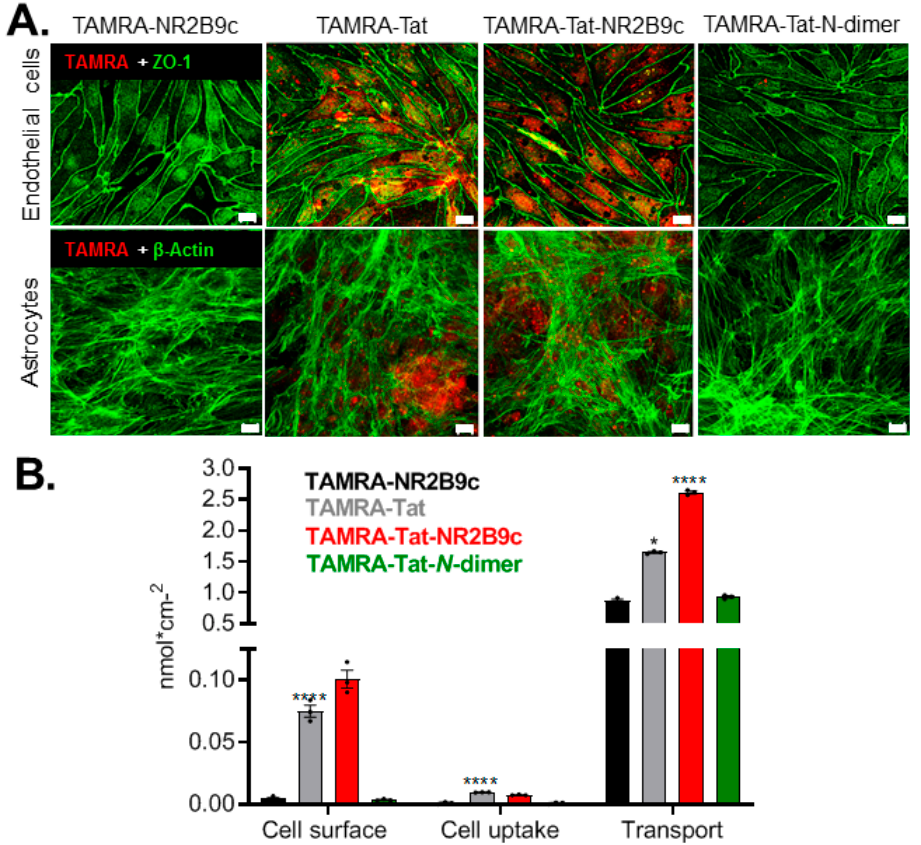
Figure 3. Adherence, uptake, and permeation following application of 100 µM TAMRA-NR2B9c, TAMRA-Tat, TAMRA-Tat-NR2B9c, or TAMRA-Tat- N -dimer to the in vitro BBB model for 3 h. ( A )